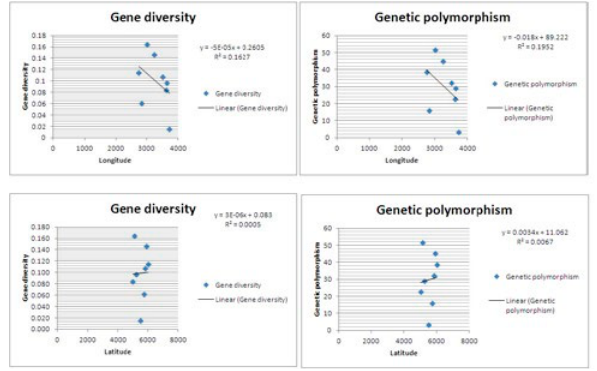
Figure 5. Correlation analysis of genetic diversity and genetic poly- morphism with geographical features in Z. Jujube populations.